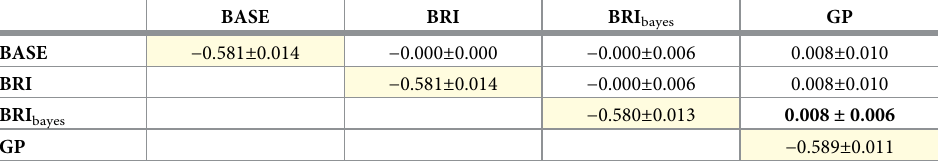
Table 3. Model performance on ATP data set.